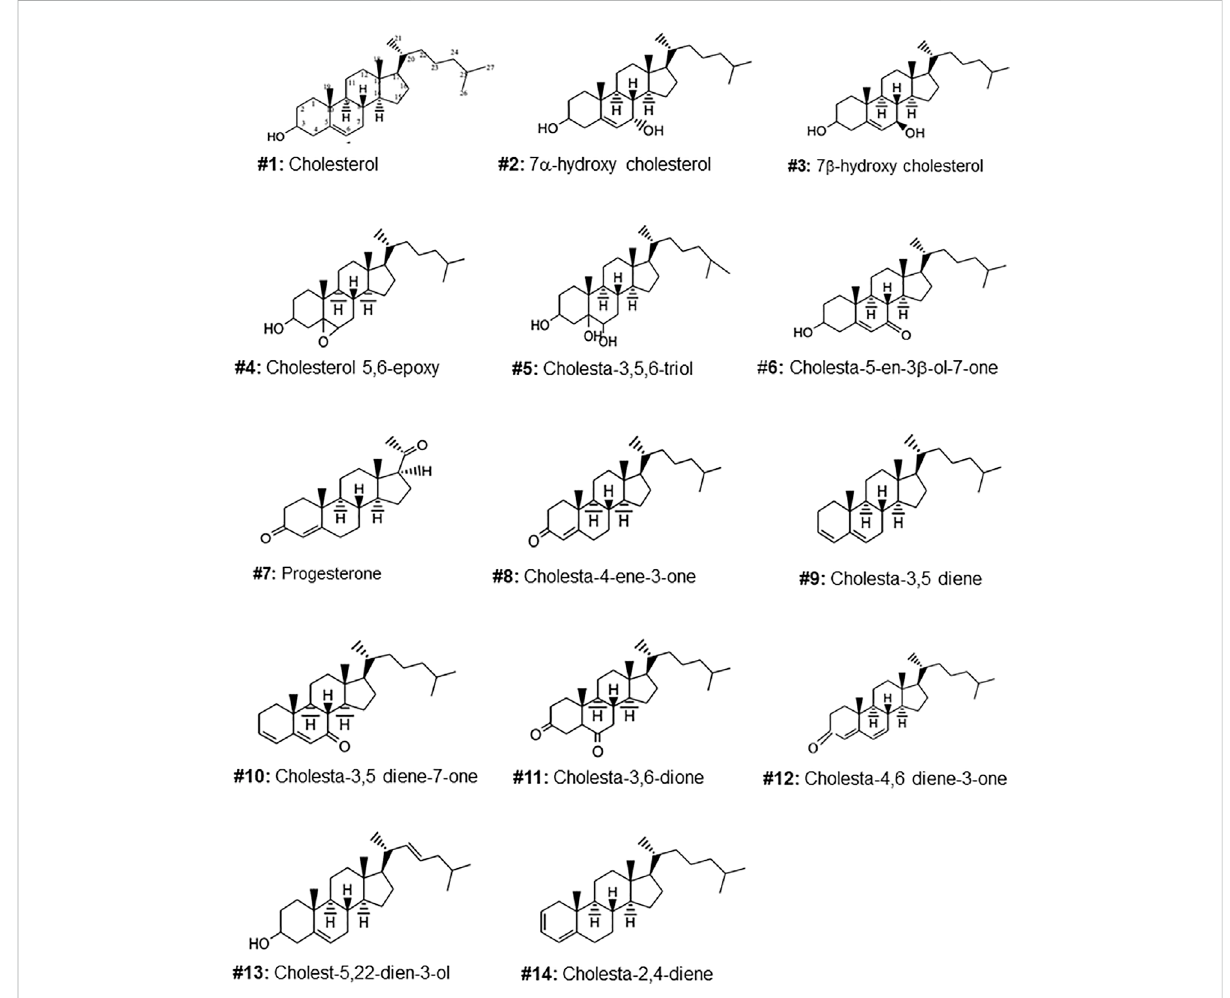
FIGURE 1 Molecular structures of the steroids isolated from the gel of Arius bilineatus . Each structure isassignedwith a number to annotate further in the manuscript